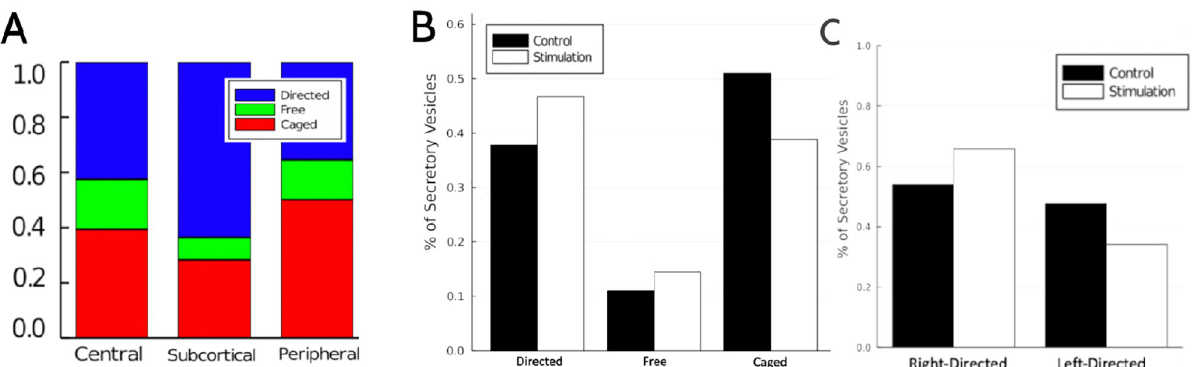
Fig 7. Steady state simulation results: A Intra-compartmental proportions in stimulated cells. B Percentages of secretory vesicles in each motile state. C Percentages of secretory vesicles undergoing direction motion (right vs left).